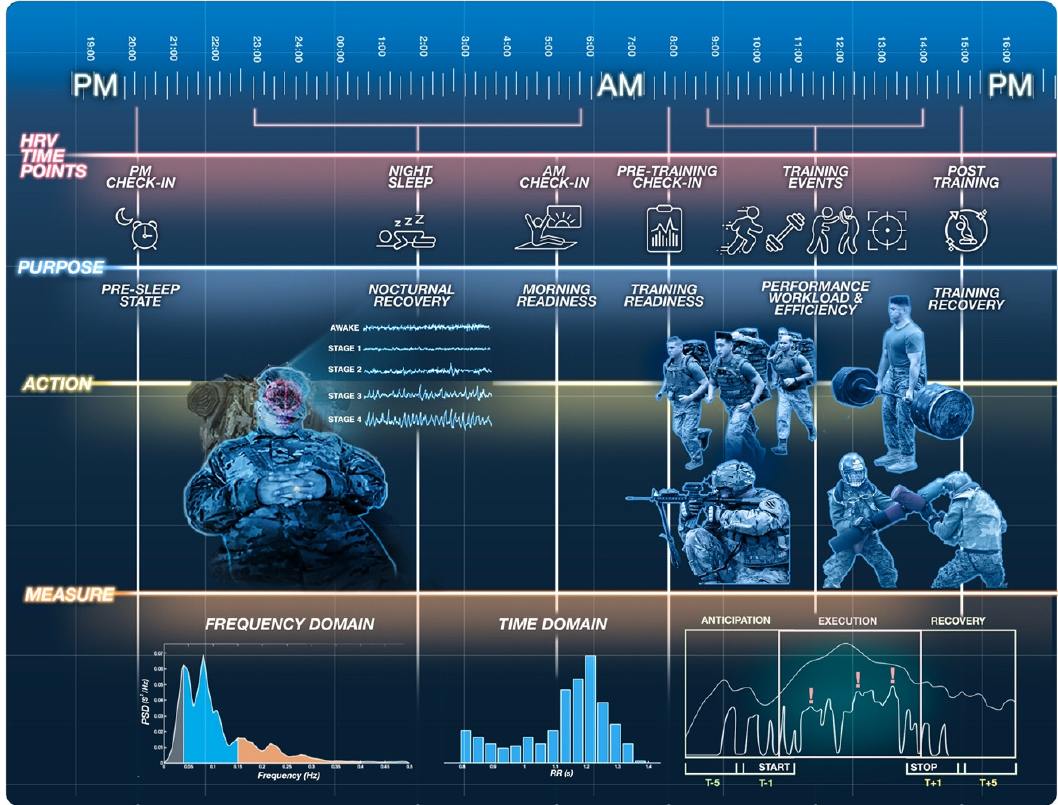
Figure 3. Opportunities within tactical populations for heart rate variability (HRV) collection throughout the day. Pre-sleep HRV assessments inform end of day status, daily resource consumption, and can quantify daily workload. During sleep, HRV provides insight on nocturnal recovery, homeostatic restoration, and daily readiness. Pre- and post-training HRV spot checks may inform acute preparedness for and recovery from training. During events, HRV can provide insights on performance workload and efficiency.